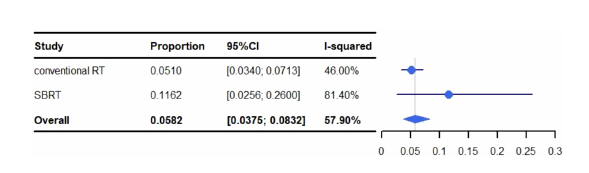
FIGURE 5 Meta-analysis and forest plots for non-small cell lung cancer